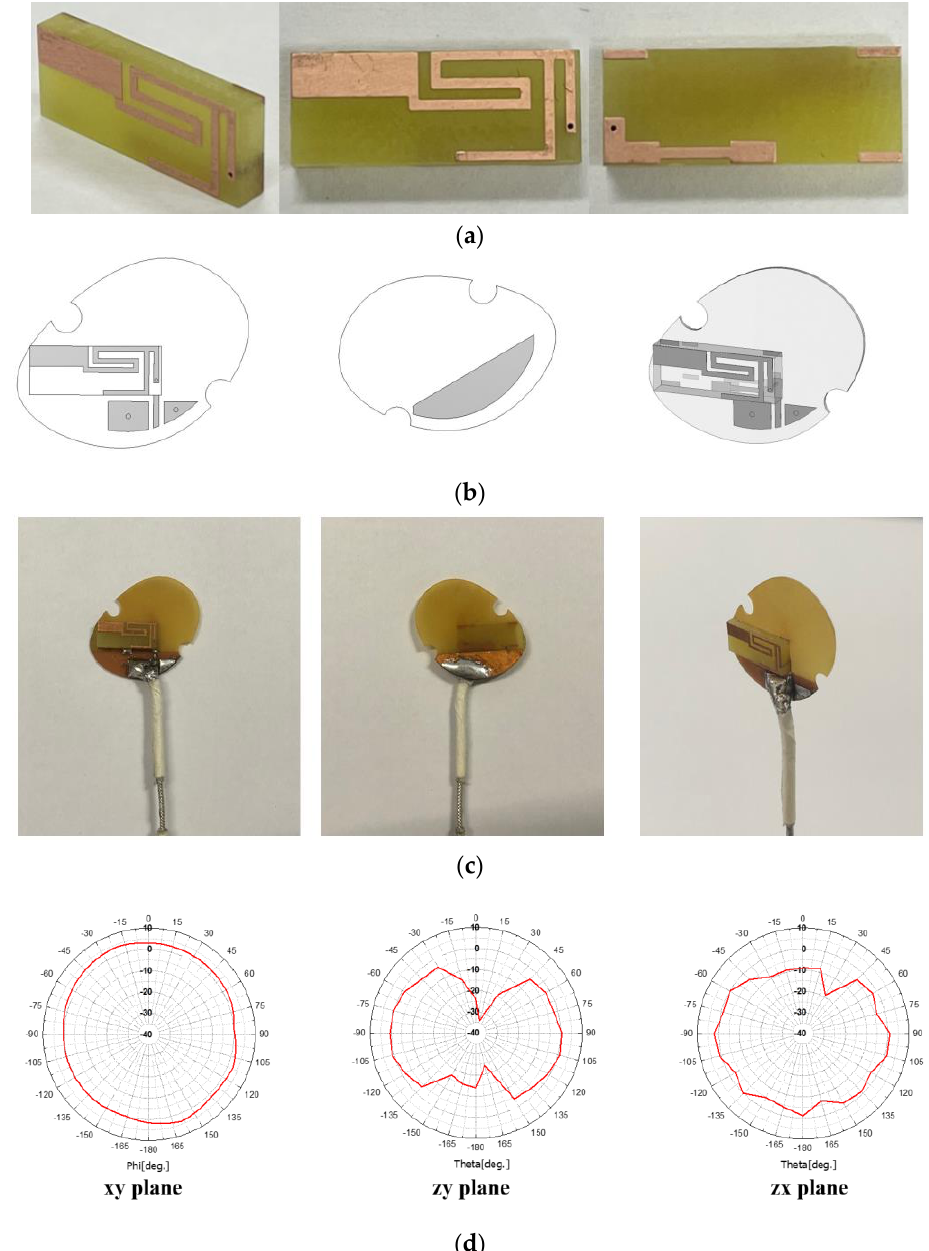
Figure 5. Fabricated antenna and measurement. ( a ) Geometry ( b ) CAD of the antenna on the PCB; ( c ) placing the antenna on the PCB; ( d ) measured far-field patterns on xy-, zy-, zx-planes.